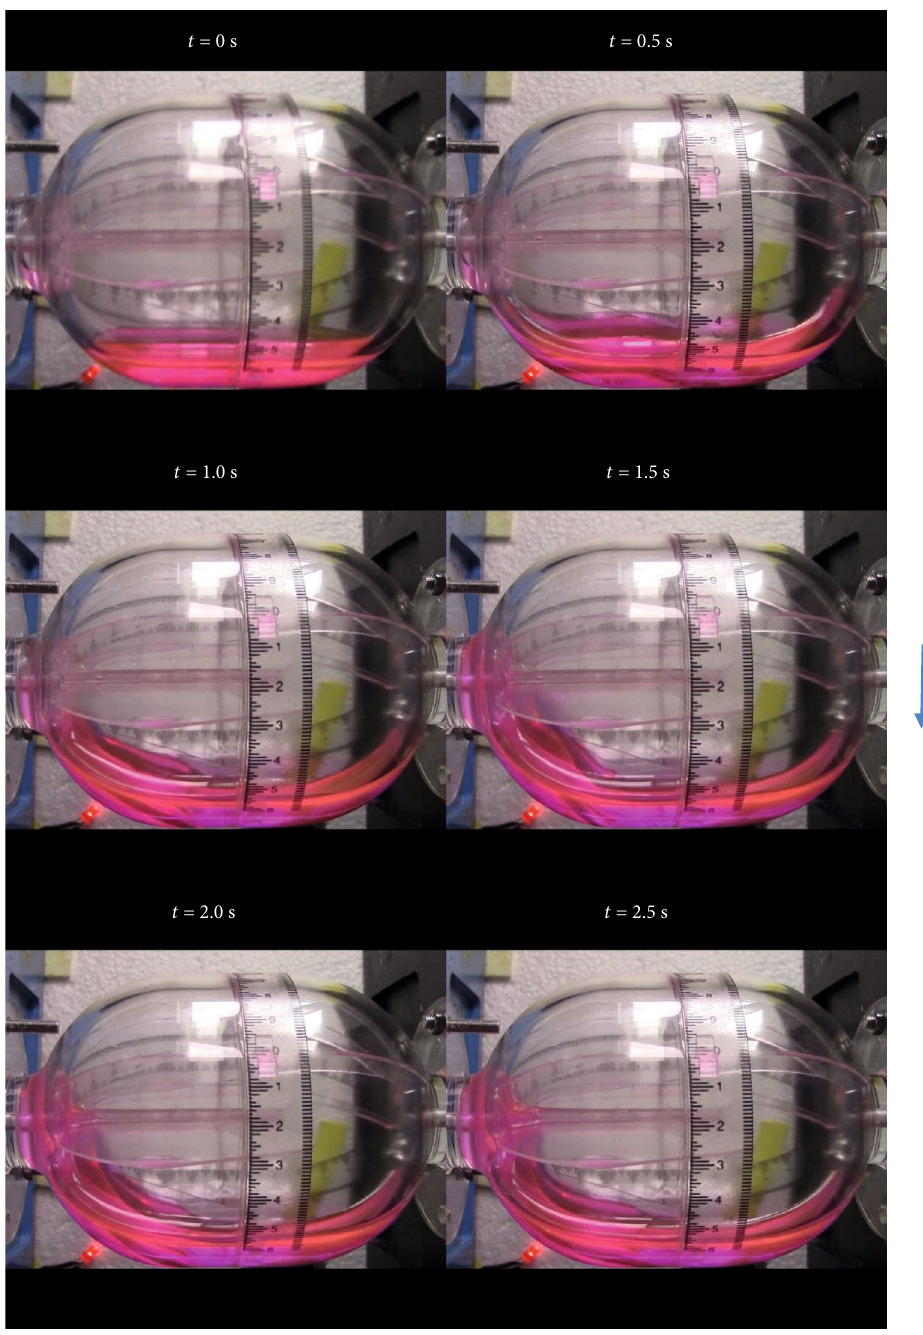
Figure 13: Liquid volume fraction is